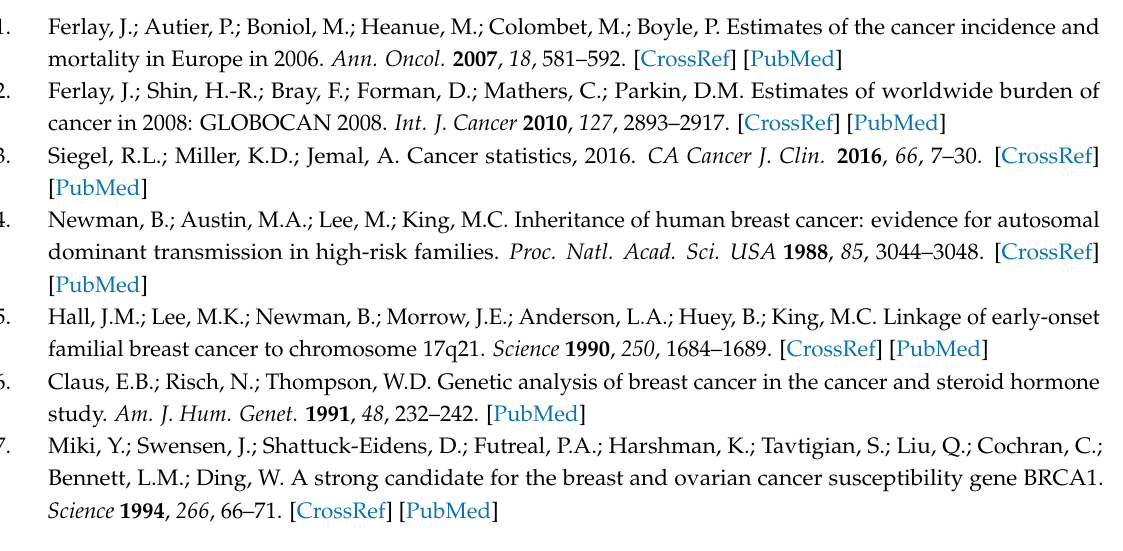
Figure S1: mRNA analysis of non-spliceogenic BRCA1 variants from PAXgene samples, Table S1: Primers for mRNA splicing, Table S2: Primers used in Real-time qPCR, Table S3: Primers used for Tag-SNPs